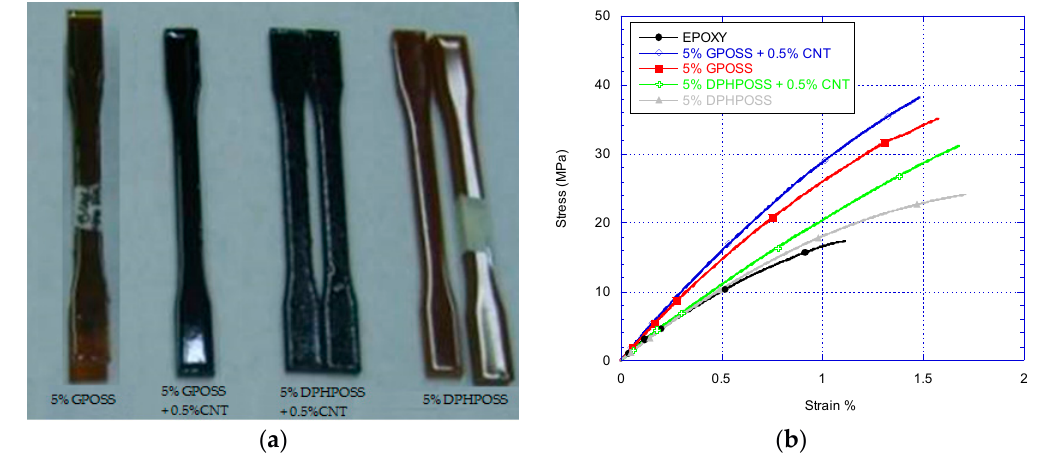
Figure 5. ( a ) Casted tensile specimens; ( b ) stress-strain curves of various epoxy nanocomposites.